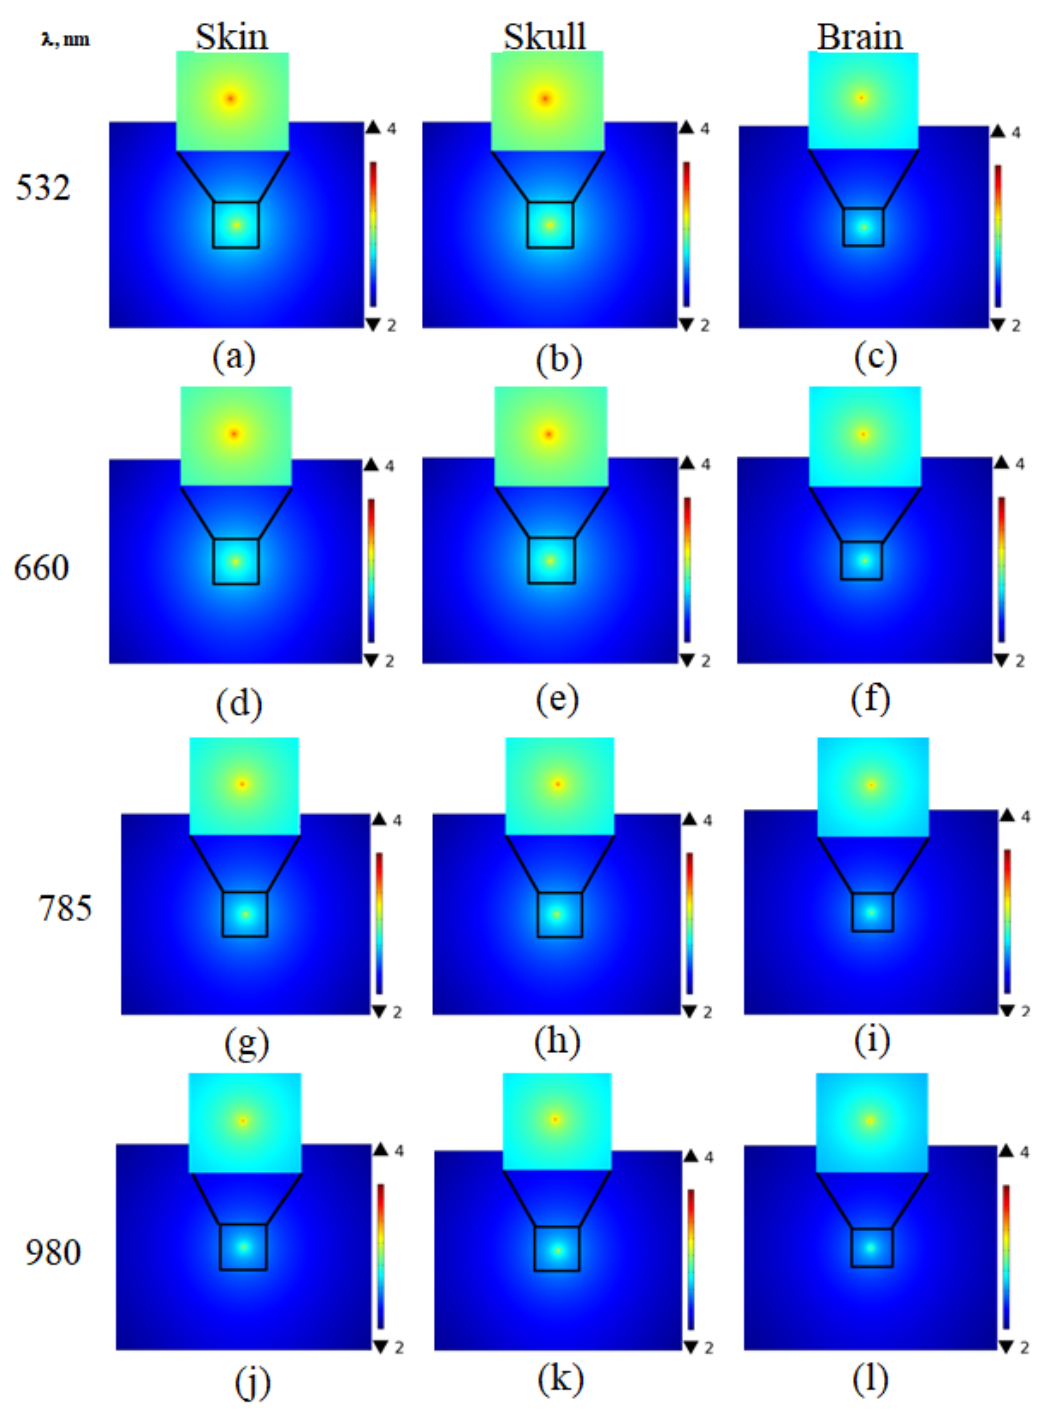
Figure 15. The fluence rate distributions at the surface outer of the skin ( a ), skull ( b ), and brain ( c ) at 532 nm; skin ( d ), skull ( e ), and brain ( f ) at 660 nm; skin ( g ), skull ( h ) and brain ( i ) at 785 nm; and skin ( j ), skull ( k ) and brain ( l ) at 980 nm.